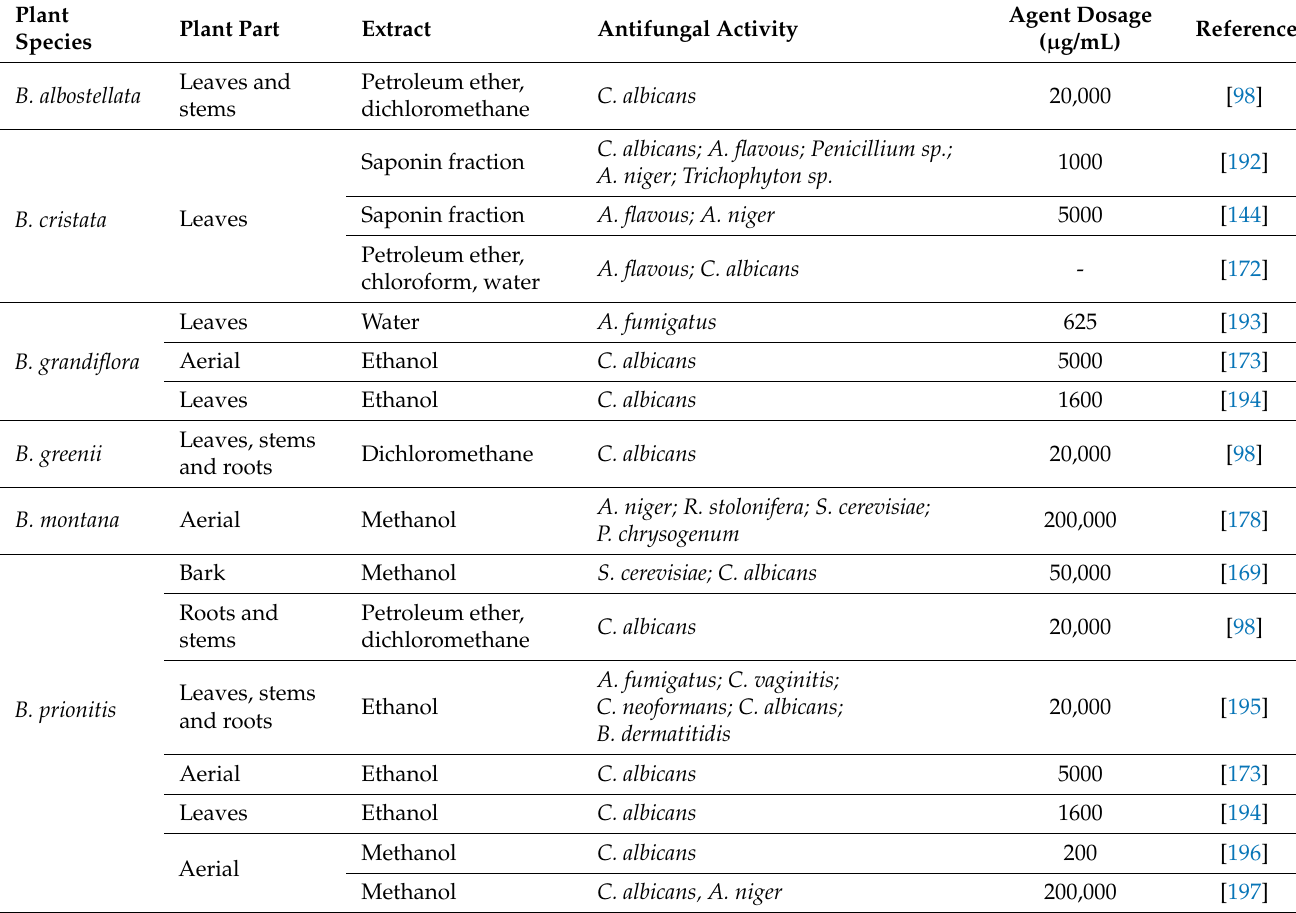
Table 4. Antifungal activities of extracts from species within Barleria